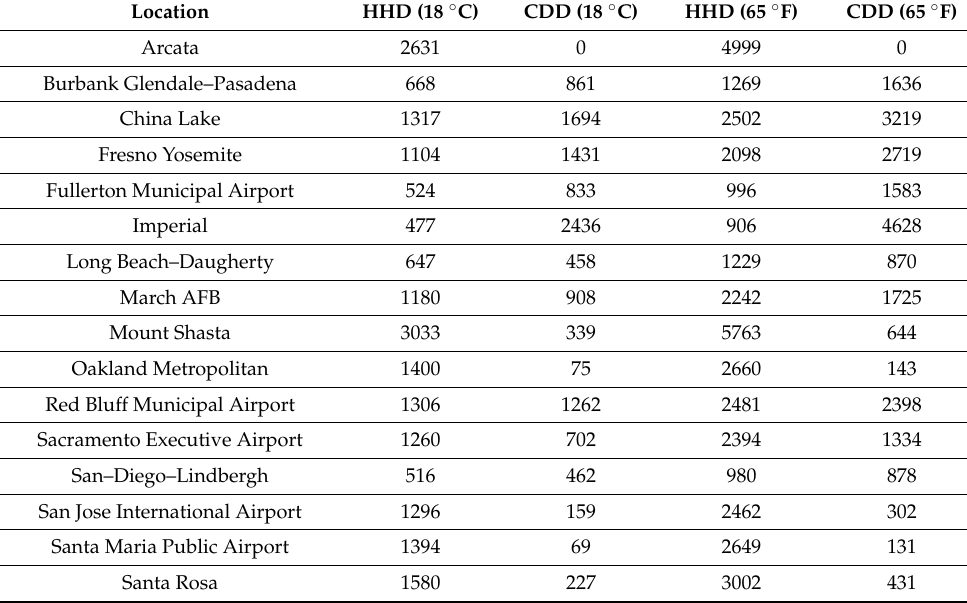
Table 2. Summary of annual heating and cooling degree days for 16 locations representative of California climate zones based on 18 ◦ C (65 ◦